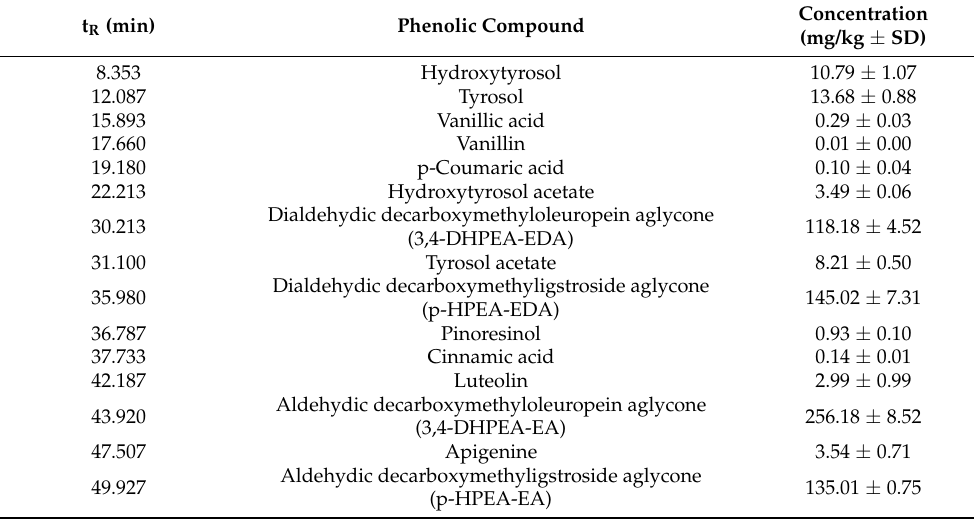
Table 2. Phenols quantified in the initial control sample